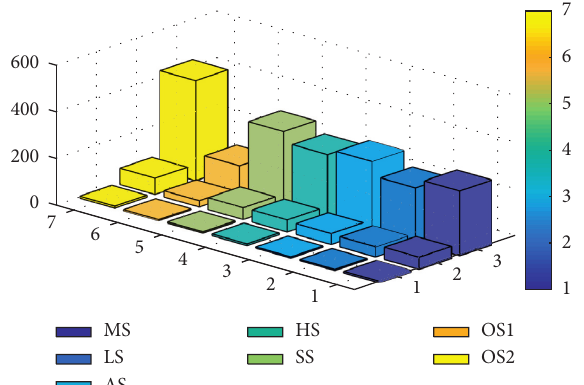
Figure 2: Difference between consecutive iterations in logarithmic scale for example